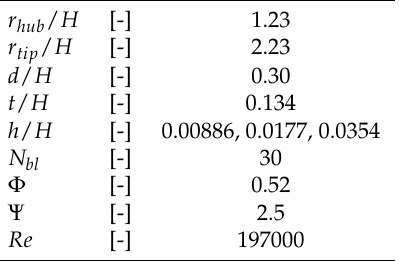
Table 1. Non-dimensional parameters of the regenerative